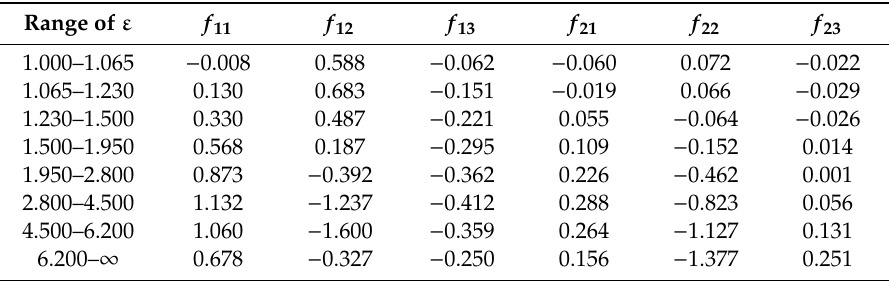
Table 1. Brightness coe ffi cients for Perez model. From